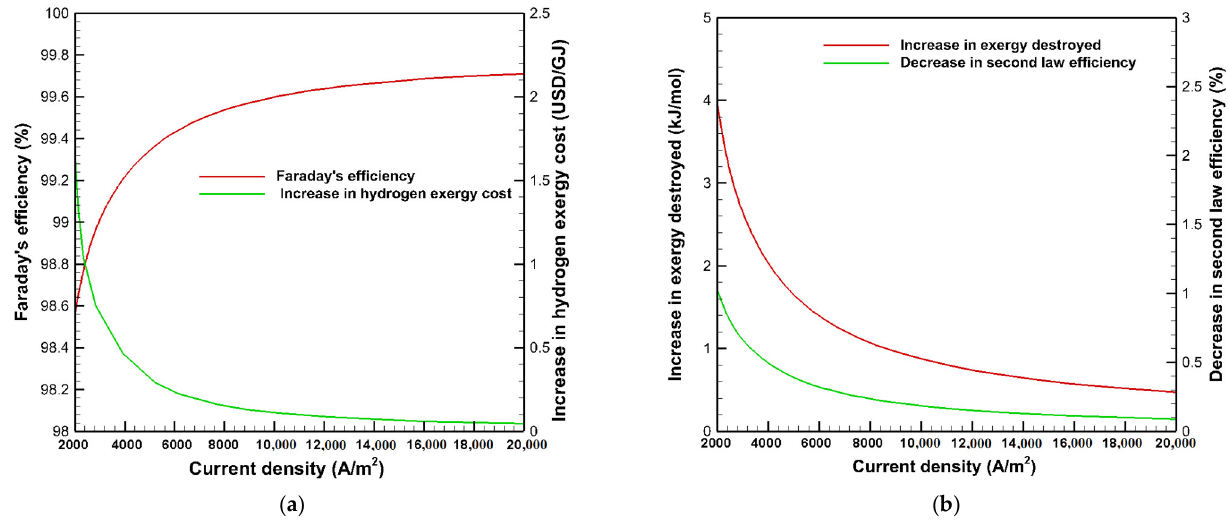
Figure 5. Effects of current density on; ( a ) Faraday’s efficiency, the increase in hydrogen exergy cost; ( b ) the increase in exergy destroyed, and the decrease in second law efficiency.